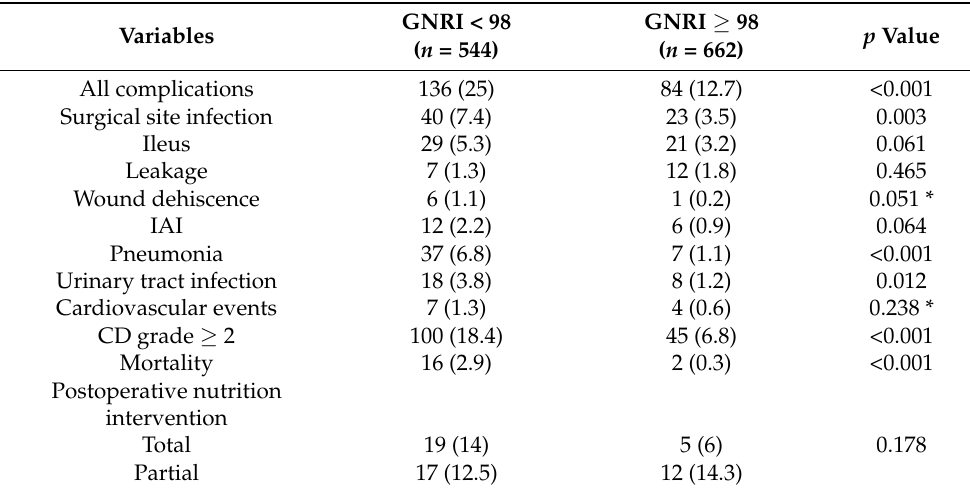
Table 3. The association of GNRI and postoperative complications in 1206 patients with CRC undergoing curative resection.